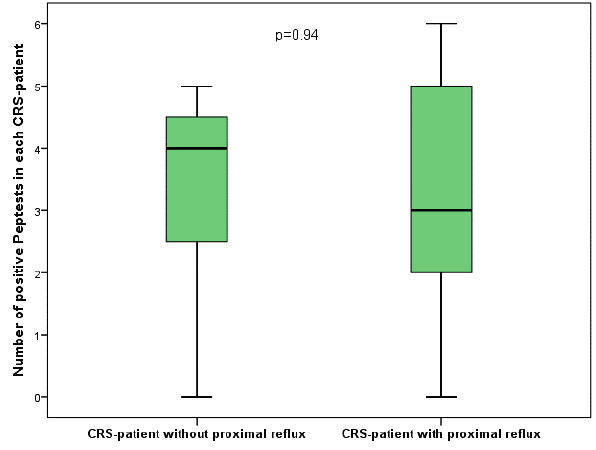
Figure 3. Total number of Peptest positive samples per CRS-patient with and without proximal reflux, diagnosed with 24-hour pH-impedance monitoring. There was no significant difference, p= 0.94.